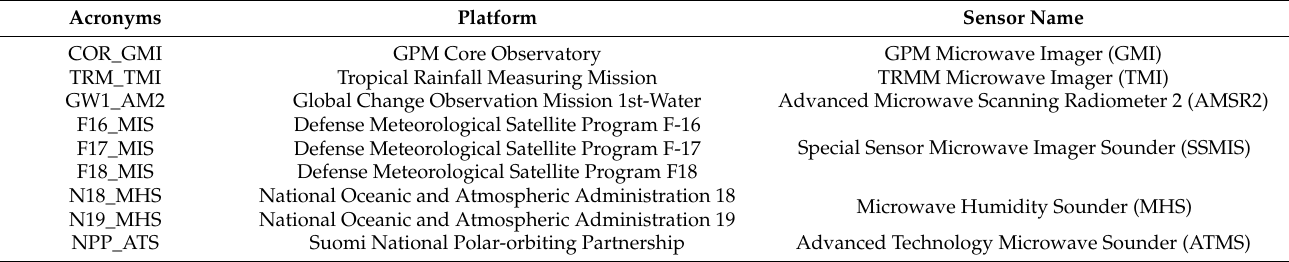
Table A1. Acronyms of the Platforms and the PMW sensors used in this